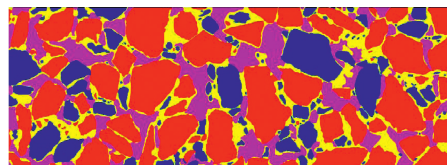
Figure 3: Segmentation of the cross-sectional